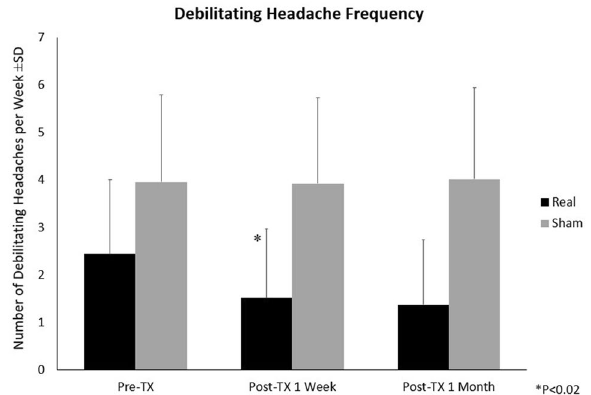
Figure 4. Debilitating Headache Frequency. Pre-Tx: Pre-treatment; Post-Tx: Post-treatment; * P < 0.02. Analysis was conducted using SPSS version 23.